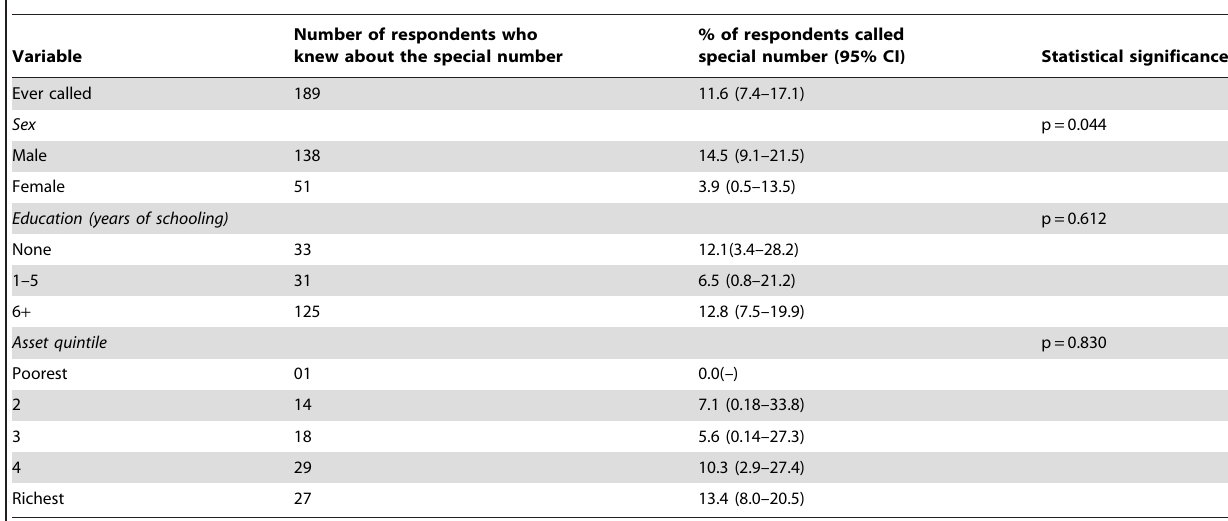
Table 5. Calling of the mHealth